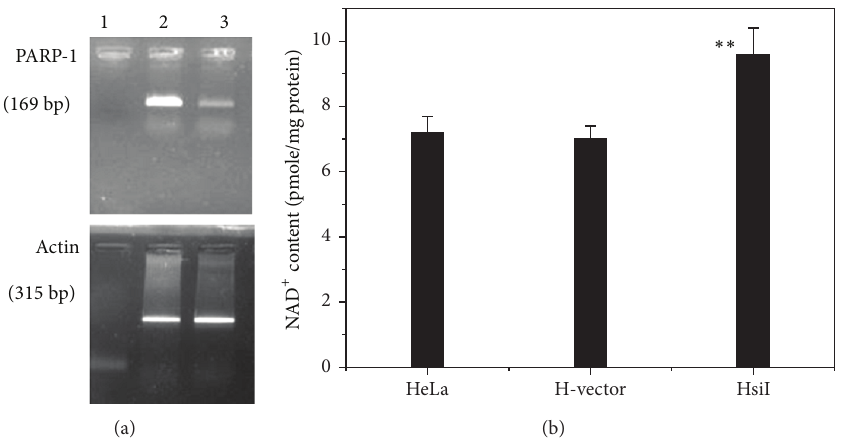
Figure 1: (a) RT-PCR for checking PARP-1 gene silencing. RT-PCR products for PARP-1 (upper panel) and beta actin (lower panel). Lanes 1, 2, and 3 represent negative control, HeLa, and HsiI, respectively. (b) Bar diagram for NAD + content (pmole/mg protein) in HeLa, H-vector, and